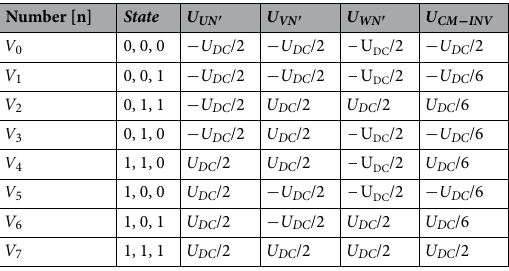
Table 1. Inverter CM voltage U CM